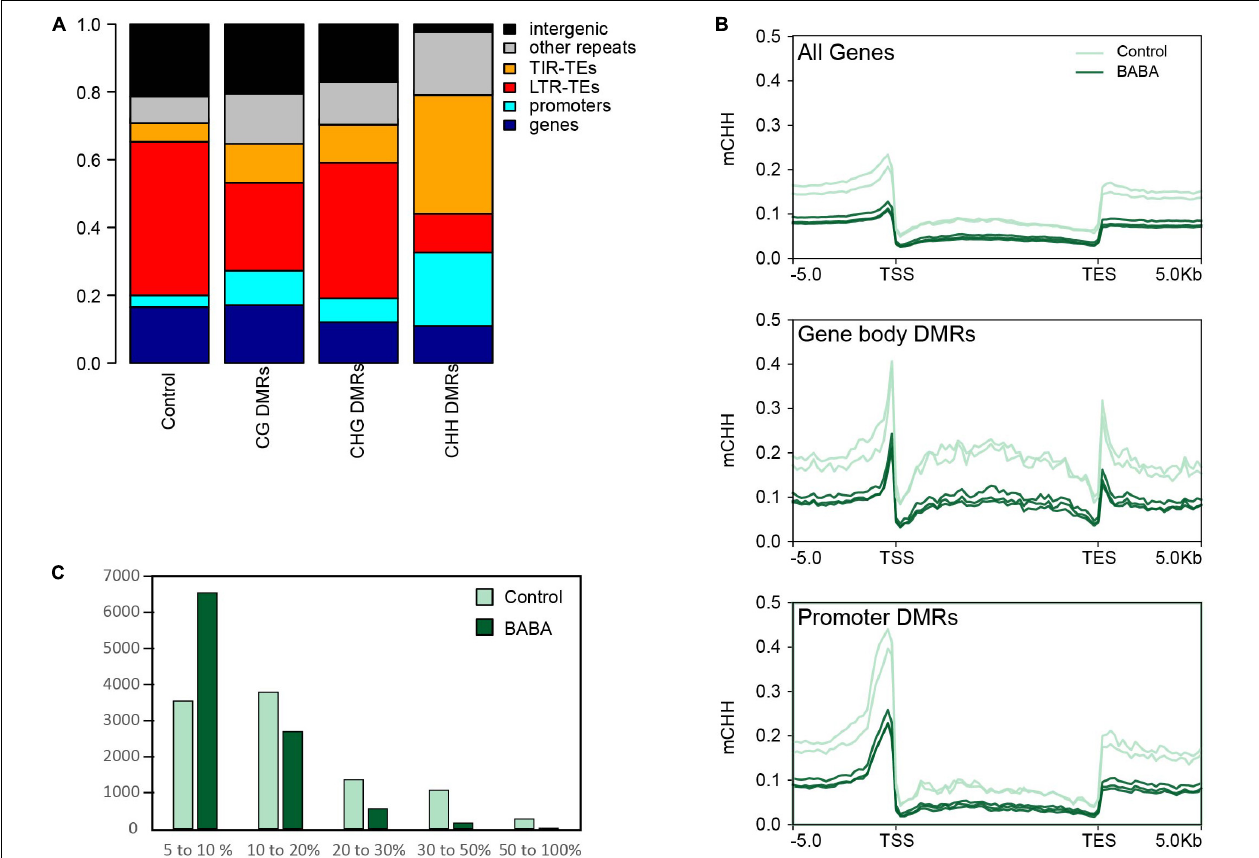
FIGURE 2 | Distribution patterns of altered methylation. (A) Stacked bar plot displaying the proportions of BABA-induced DMRs overlapping different genomic features on the tomato genome. Data are shown for CG DMRs ( n = 14,345), CHG DMRs ( n = 24,941) and CHH DMRs ( n = 11,709) and compared with the overlap found for a control set of 10,000 randomly selected regions of 200 bp. Promoters are defined as the DNA sequence located 1 kb upstream of the transcription start site of each annotated gene. (B) Averaged CHH methylation profiles across standardised tomato gene models for all tomato genes ( n = 35,768) and genes overlapping DMRs in their gene body ( n = 1,152) or in their promoter ( n = 2,865). Plots show proportions of methylated cytosines for control (pale green) and BABA primed (dark green) methylomes. (C) Frequency histogram showing numbers of genes with different levels of total CHH methylation (%) in control and BABA-treated